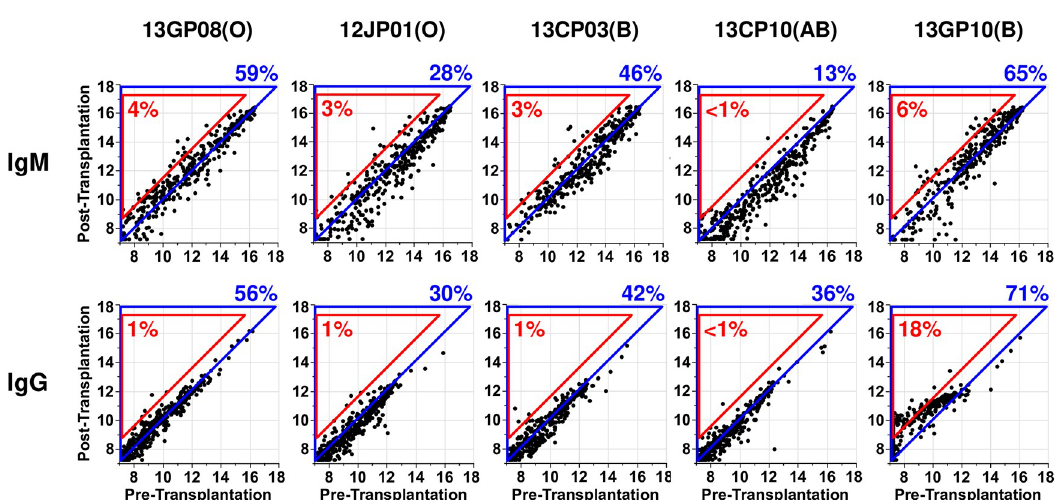
Fig 2. Comparison of antibody signals in each monkey. Signals for each carbohydrate in posttransplant serum were plotted against pretransplant na ï ve serum. Signals are on the log 2 scale. The plots in a blue triangle represent carbohydrate antigens that are increased in the posttransplant serum. The plots in a red triangle represent carbohydrate antigens that are significantly increased (the changes of normalized signal intensity � 1.5) in the posttransplant serum. The blood type of a monkey is noted in brackets.